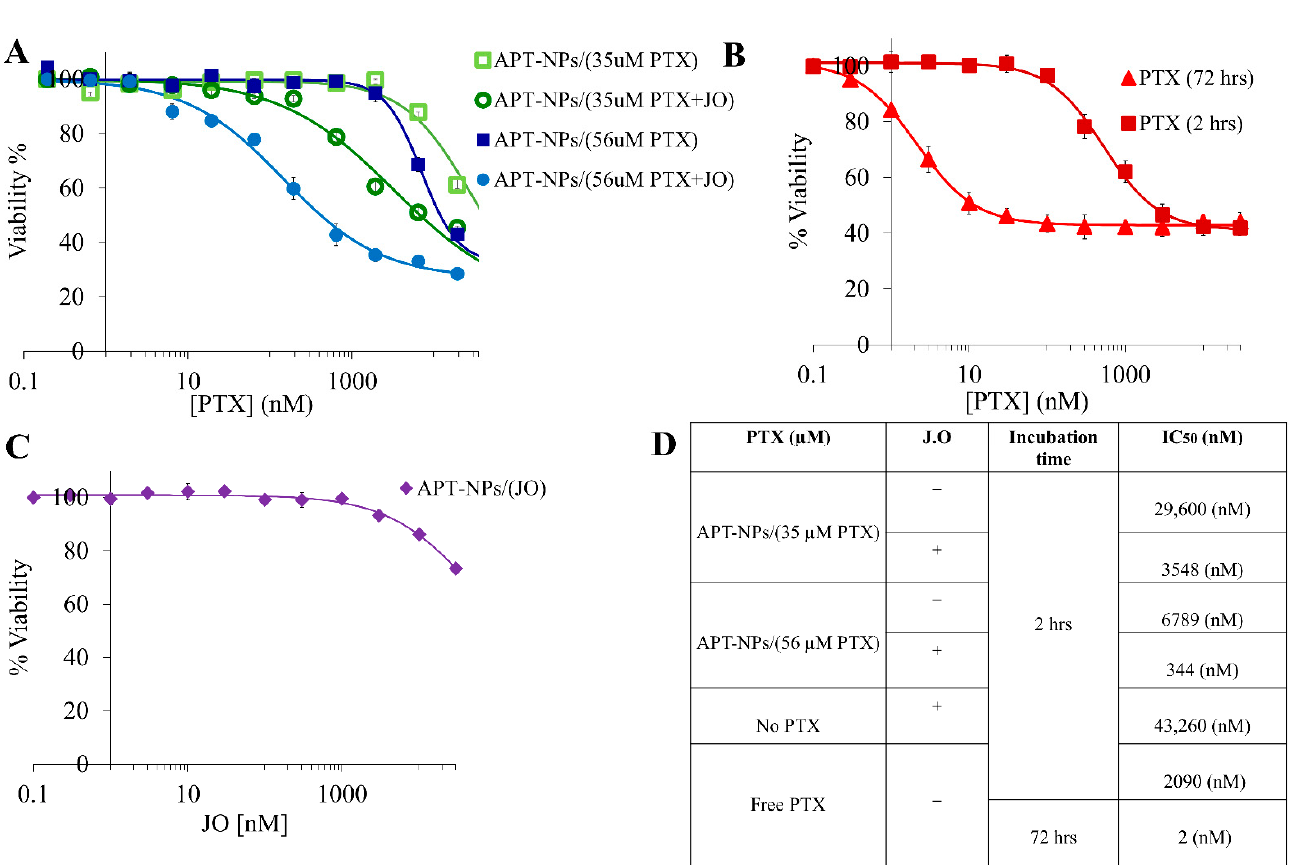
Figure 6. A549 cell viability as a function of PTX or JO concentration for ( A ) APT-NPs entrapping PTX (35 and 56 µM during drug loading) with or without JO; ( B ) free PTX was added to A549 cells for 2 or 72 h; ( C ) APT-NPs entrapping 88 µM JO. Values presented are means ± SE. Sigmoidal model curves were fitted using OriginPro 9.0 [14]; ( D ) IC 50 values derived from the fitted dose–response curves; all p -values obtained were <0.05.